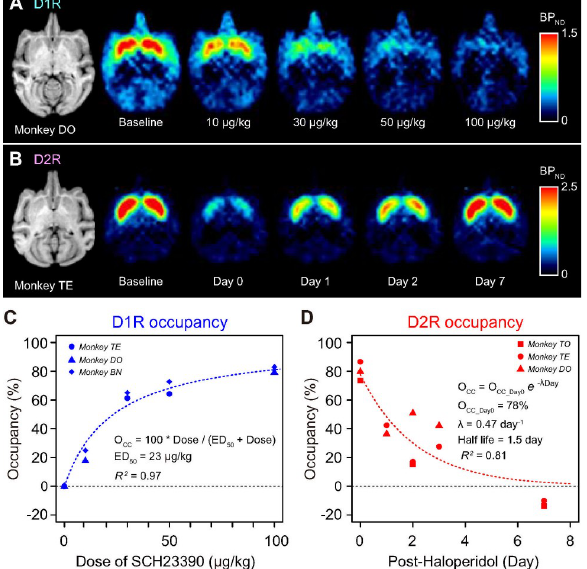
Fig 1. D 1 R and D 2 R occupancy measured by PET. (A) Representative horizontal MR (left) and parametric PET images showing specific binding (BP ND ) of [ 11 C]SCH23390 at baseline and following drug treatment with SCH23390 (10, 30, 50, or 100 μ g/kg, i.m.). (B) Representative horizontal MR (left) and parametric PET images showing specific binding (BP ND ) of [ 11 C]raclopride at baseline and on 0 to 7 days after injection with haloperidol (10 μ g/kg, i.m.). Color scale indicates